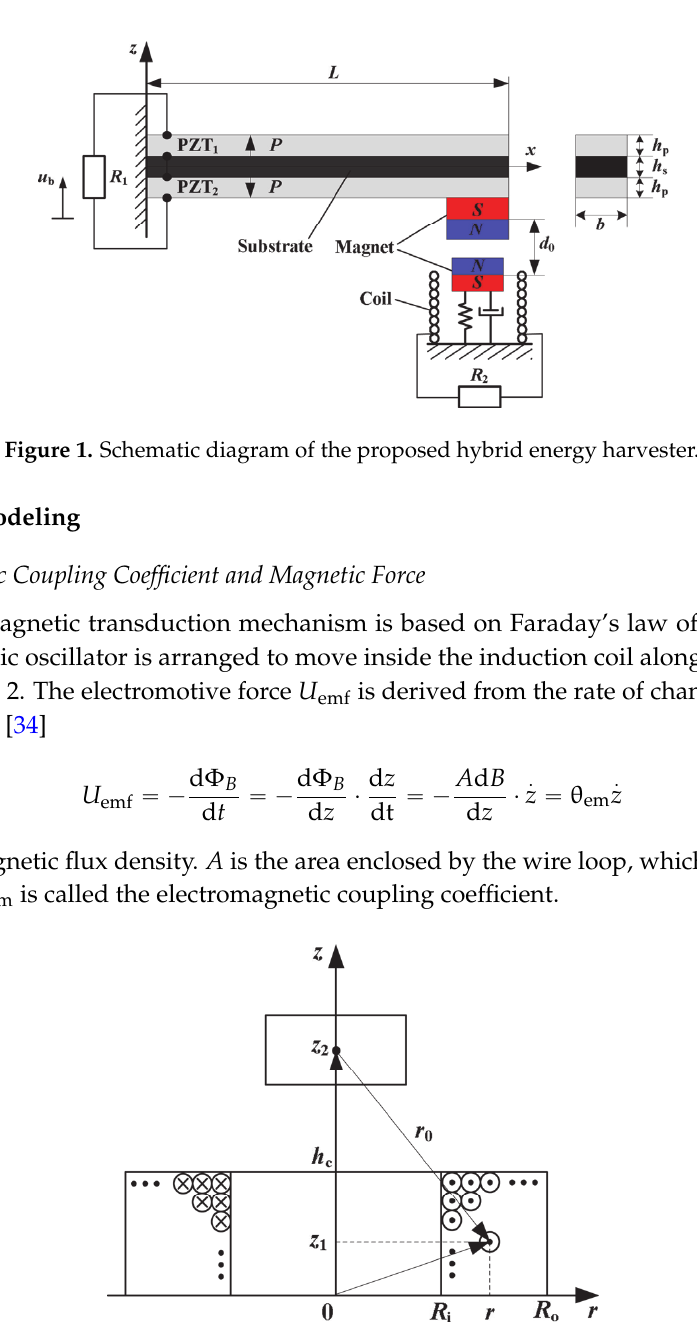
Figure 2. The relative position between magnet and coil.